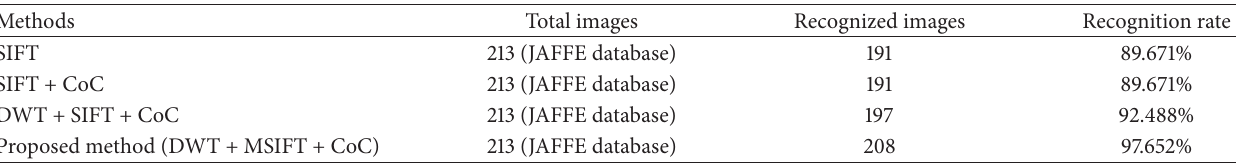
Table 2: Experimental results of recognition of images.